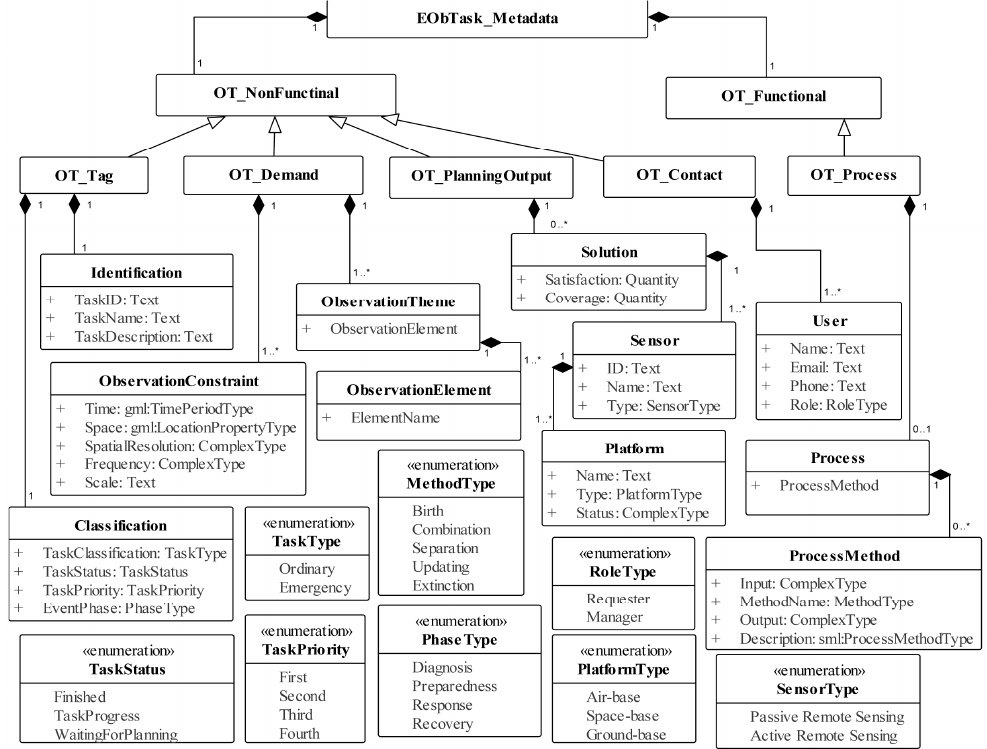
Figure 4. UML diagram for earth observation task metadata contents. (1..*: at least one instance, 0..*: zero or more instances).